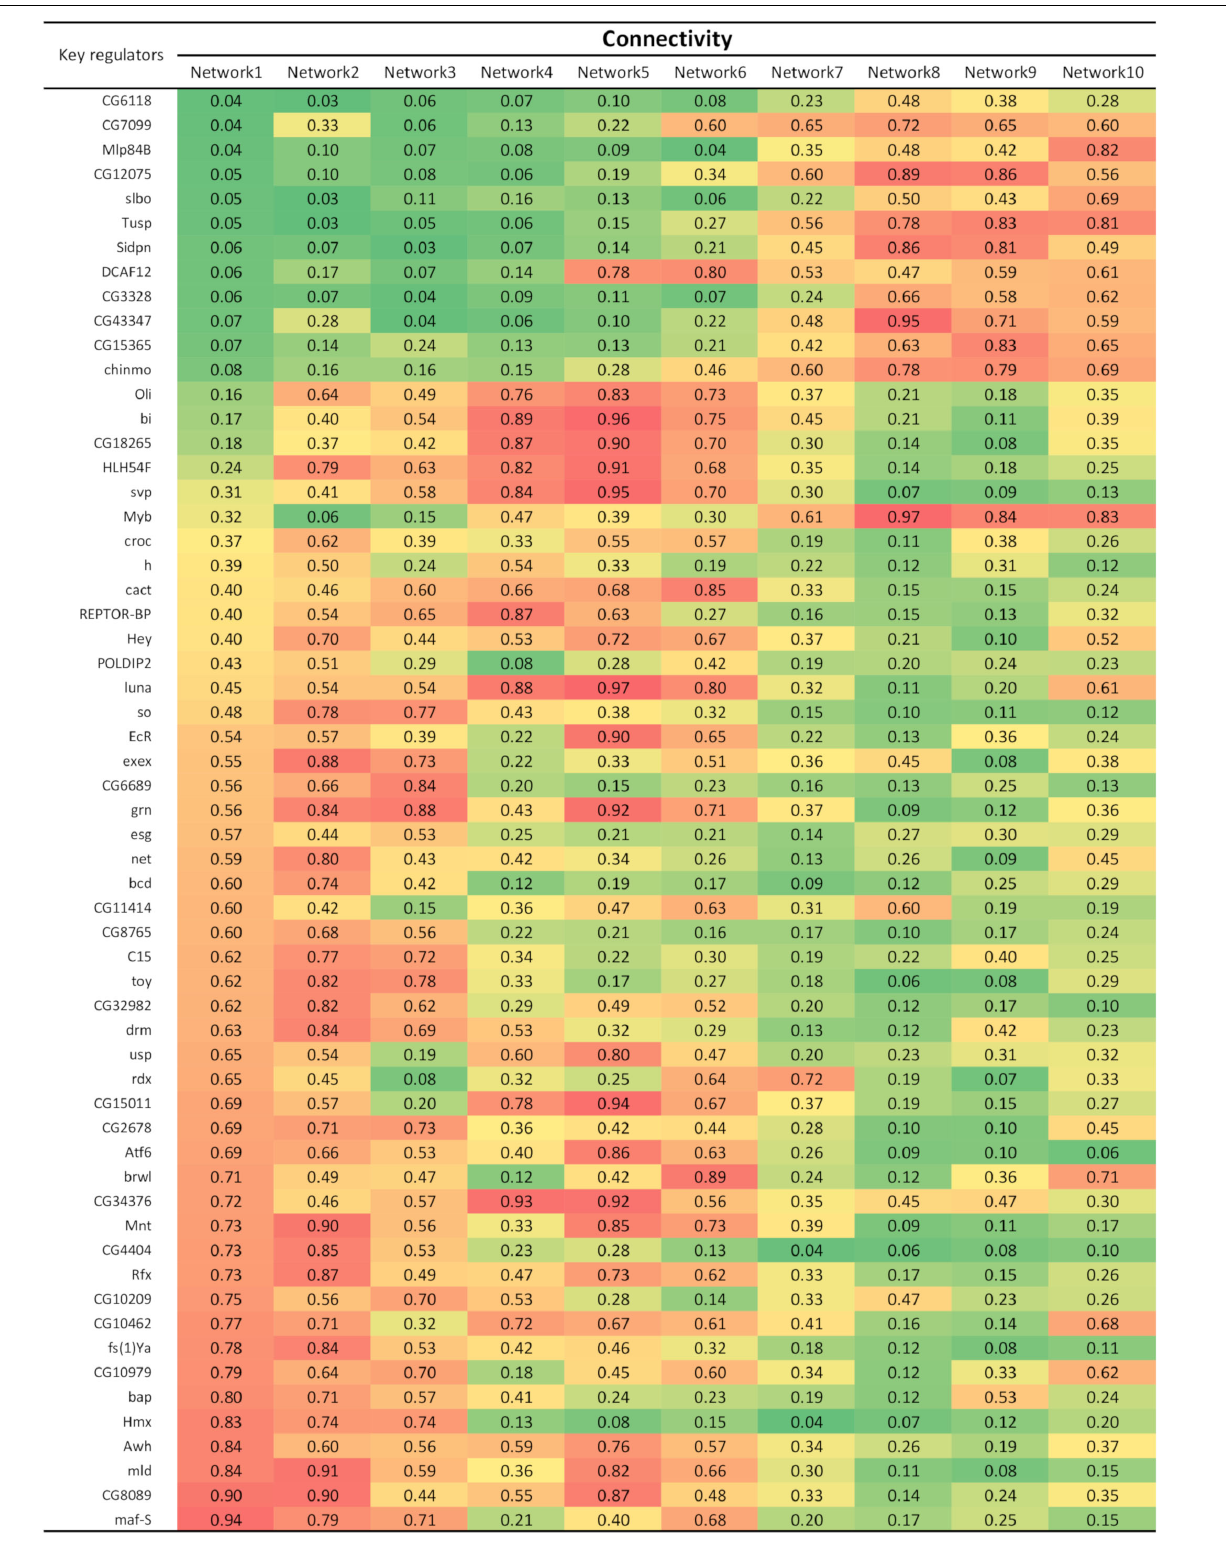
Frontiers in Genetics |